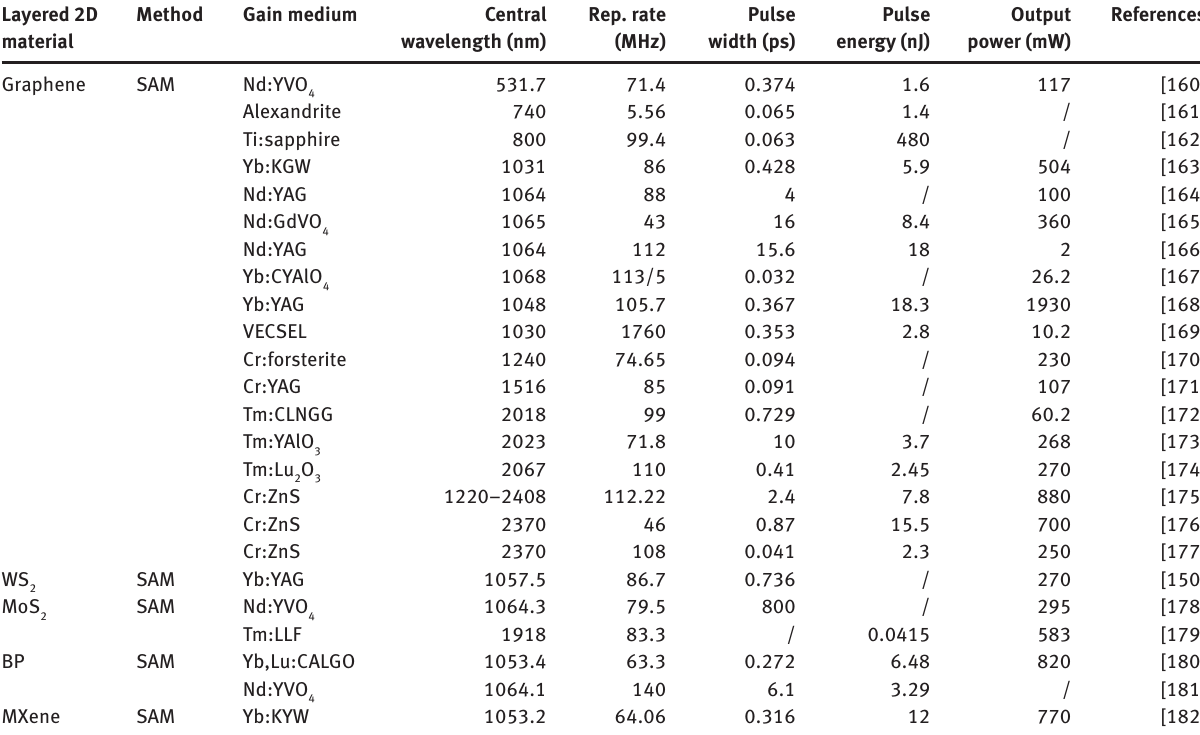
Table 2: Summary of mode-locked solid-state lasers based on layered 2D materials. Layered